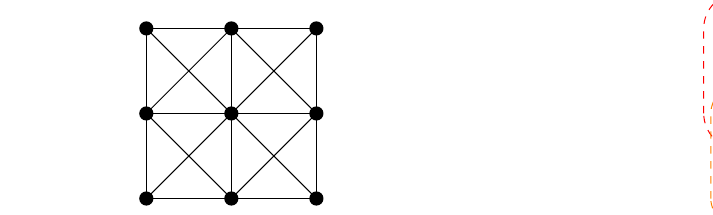
v 1 Figure 4: The transport method proposed in this pa- per. Our distance acts to combine the transport in the same hyperedge as